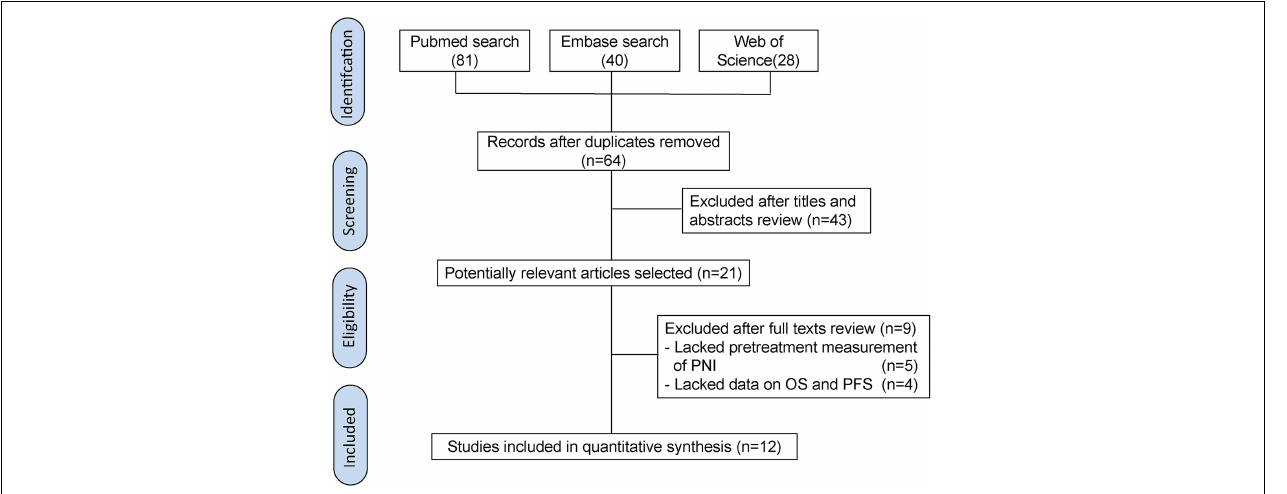
FIGURE 2 | Meta-analysis of impact of PNI on overall survival of patients treated with immune checkpoint